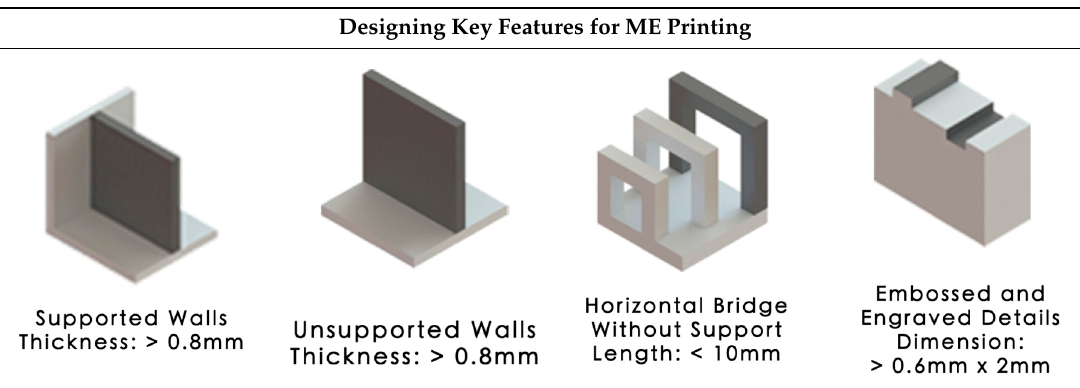
Table 6. Design rules for ME [2,60].